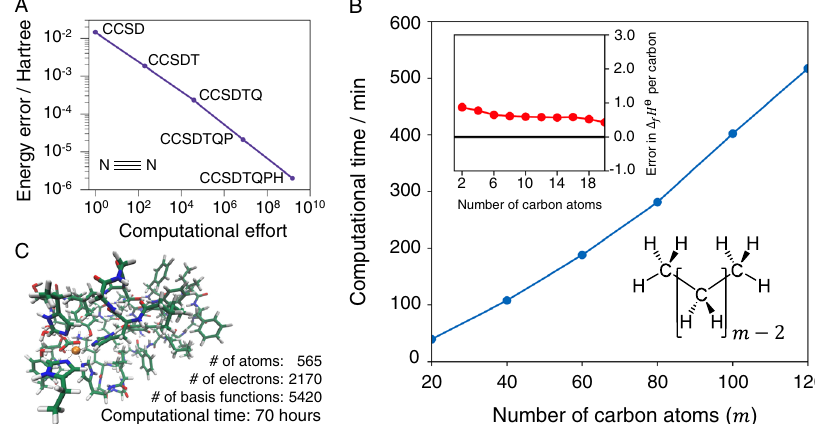
Fig.3|Computationalcomplexityofclassicalheuristicsformolecularsystems. A Energy error of a nitrogen molecule (equilibrium geometry) as a function of the level of CC approximation, against a computational time metric. Data taken from ref.37,timemetricde fi nedinSupplementaryNote3.7.Theobservedprecisioncost is like poly(1/ ϵ ). B Cost of a state-of-the-art reduced-scaling coupled-cluster (CCSD(T)) implementation scales nearly-linearly with the system size in gapped systems, as demonstrated here for n -alkanes (C m H 2 m +2 ) with m =[20 … 120]. Size-